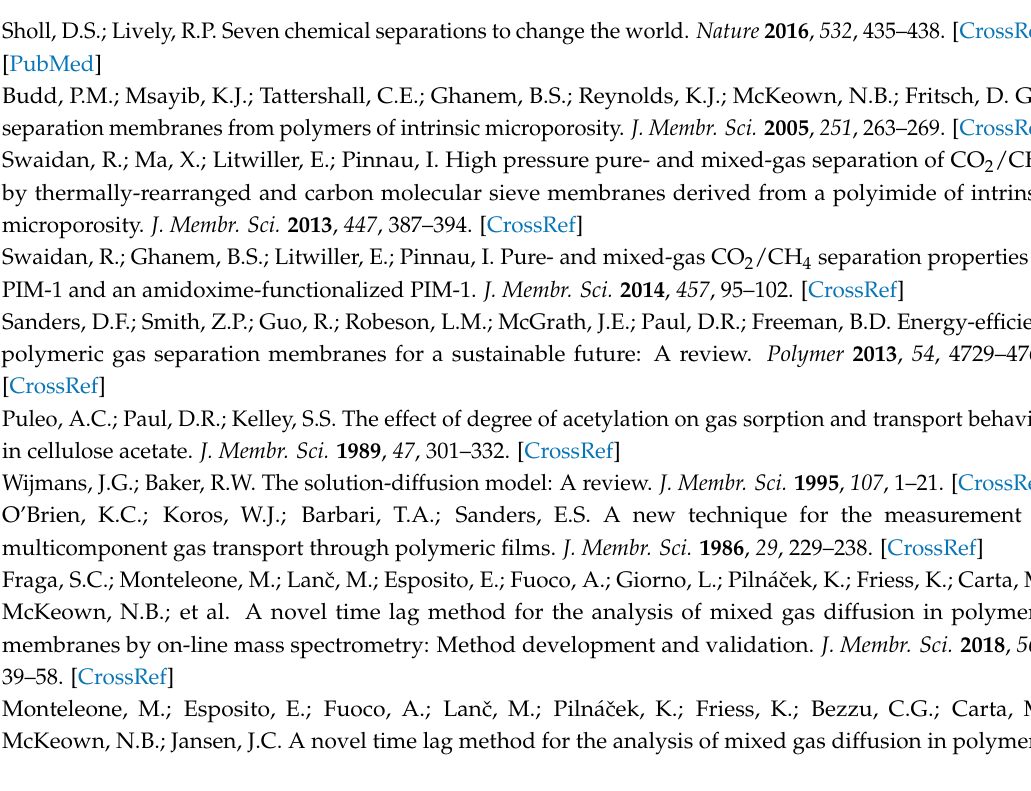
Figure S1: Data of CO 2 mixed-gas solubility vs. CH 4 mixed-gas solubility coefficient of AO-PIM-1 and polynonene [2]. For both interpolations, the slope was fixed at the value of pure-gas solubility selectivity at infinite dilution. Figure S2: In red and in blue, two examples of the behavior of the switch function (Equation S5) = 1. Figure S3: Comparison used in this work to track the behavior of K Di and b i parameters. In this graph, A pure i between experimental uptakes and model predictions for (a) CH 4 and (b) CO 2 . Black squares are predictions of the DMS-mix with pure-gas parameters. Red circles are predictions of the DMS-mix-mod. Figure S4: CH 4 (a) and CO 2 (b) mixed-gas uptakes in 6FDA-mPDA. Surfaces were obtained via the DMS-mix-mod fitting. The DMS-mix-mod allowed us to predict the solubility behavior beyond the region covered by experimental data. Figure S5: CH 4 (a) and CO 2 (b) mixed-gas uptakes in 6FDA-mPDA. Surfaces were obtained via linear interpolation. Table S1: Dual-mode model parameters of methane and carbon dioxide in 6FDA-mPDA for pure-gas sorption at 35 ◦ C. Table S2: Comparison between solubility selectivities at infinite dilution retrieved from mixed-gas and pure-gas sorption data. Table S3: Parameters derived from DMS-mix-mod fitting. Table S4: Pure- and mixed-gas uptake data presented in this